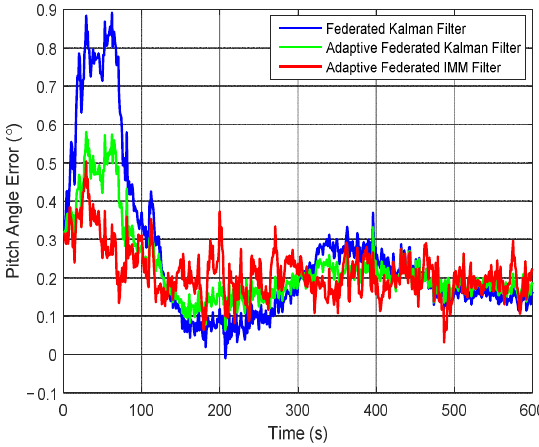
Sensors 2020 , 20 , x FOR PEER REVIEW Figure 9. The estimation curves of pitch angle. Figure 9. The estimation curves of pitch angle.